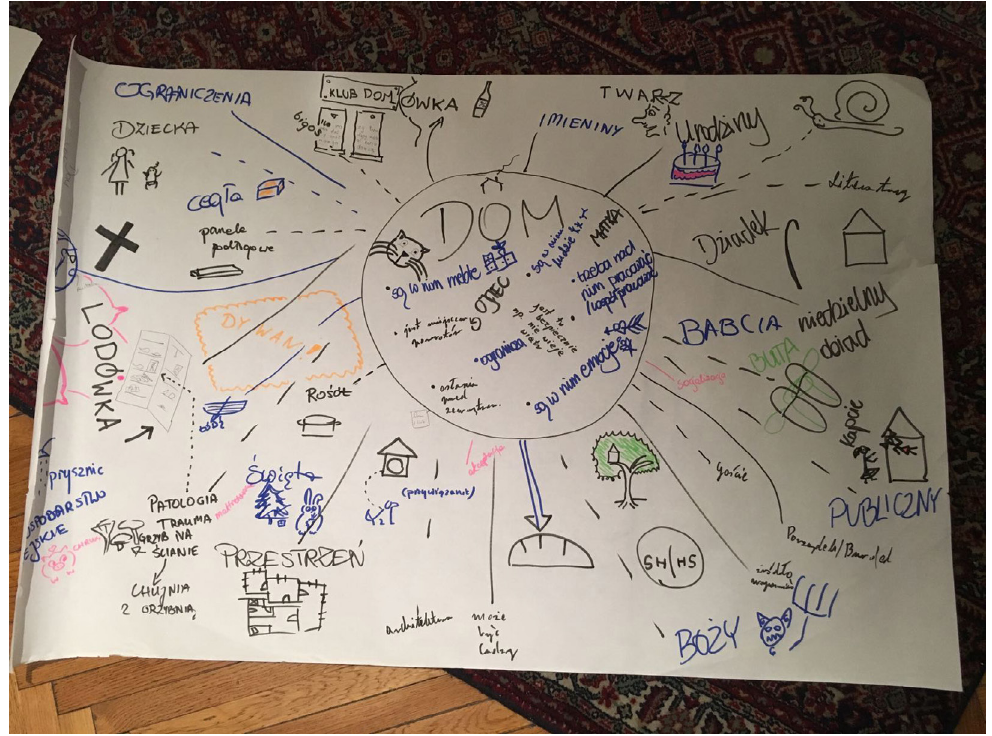
Figure 2. A poster created by participants of Rafał Gawin’s workshop at the House of Literature in Łódź, July 2017.” ©